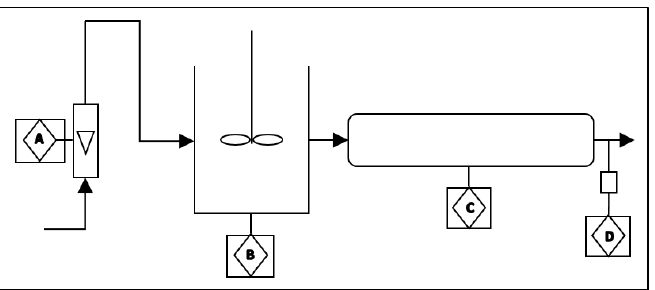
Figure 1: Laboratory-scale assembly of the stirred tank and tubular reactor system connected in series for stimulus-response studies with a 30% NaCl